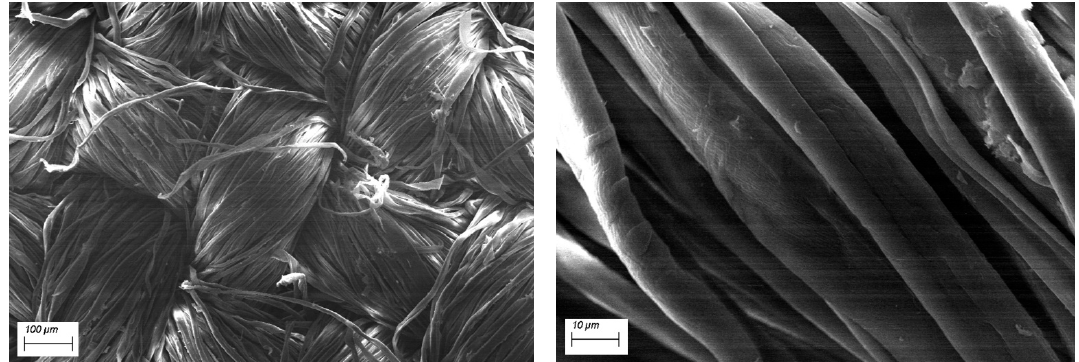
Figure 2. SEM images of untreated cotton at different magnifications.